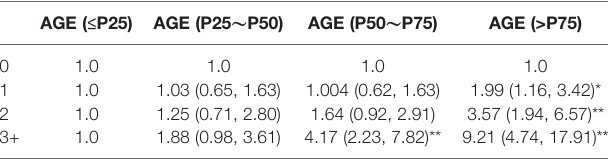
TABLE 5 | The multilevel logistic regression of number health risk factors and AGE.